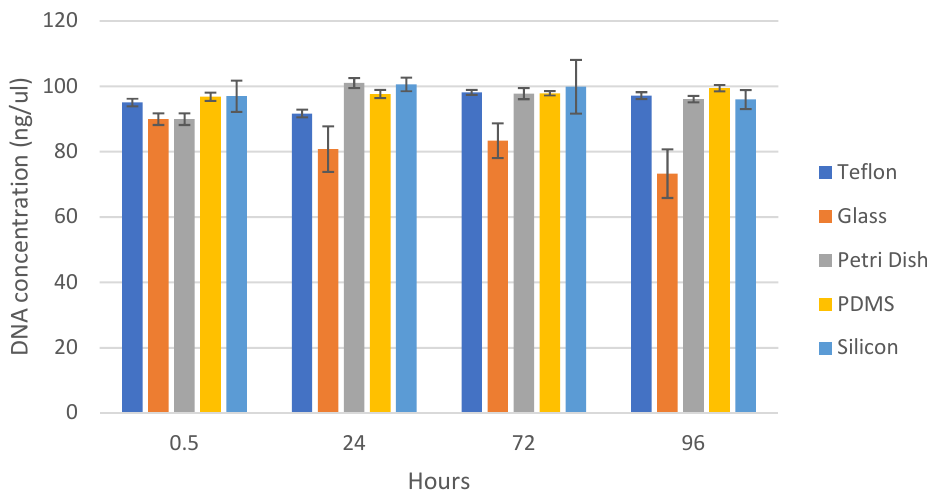
Figure 5. The mean values of the retrieved DNA from various surfaces at different times.